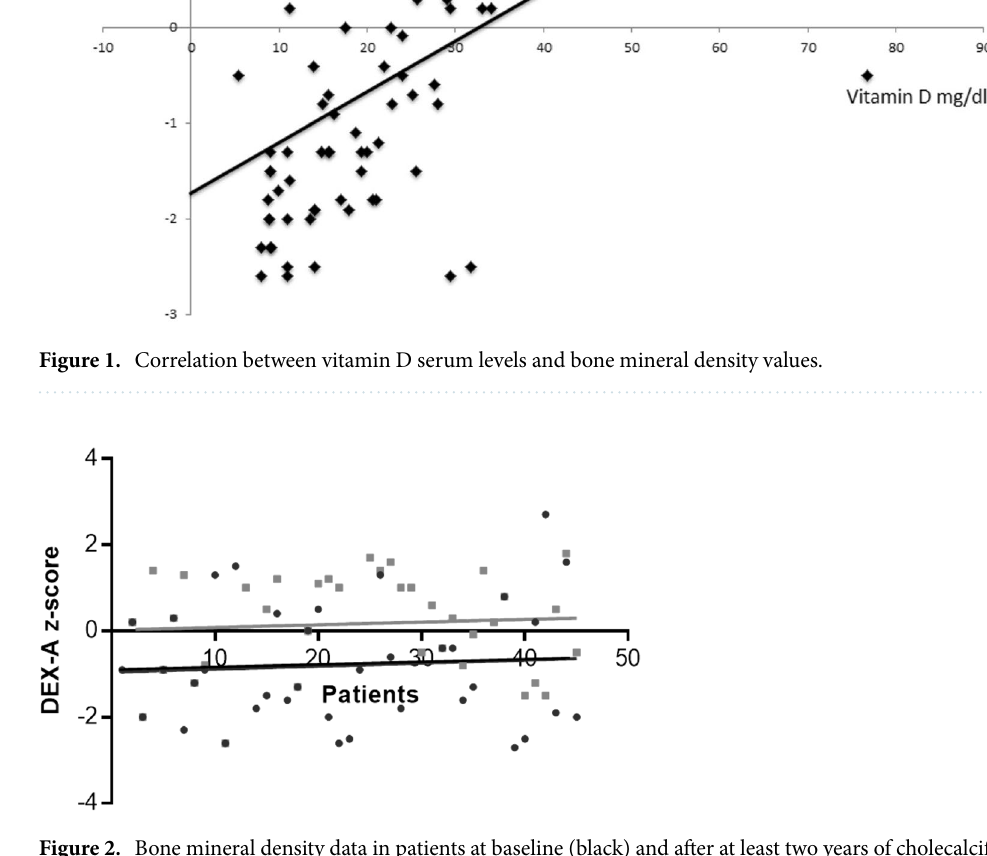
Figure 2. Bone mineral density data in patients at baseline (black) and after at least two years of cholecalciferol supplementation